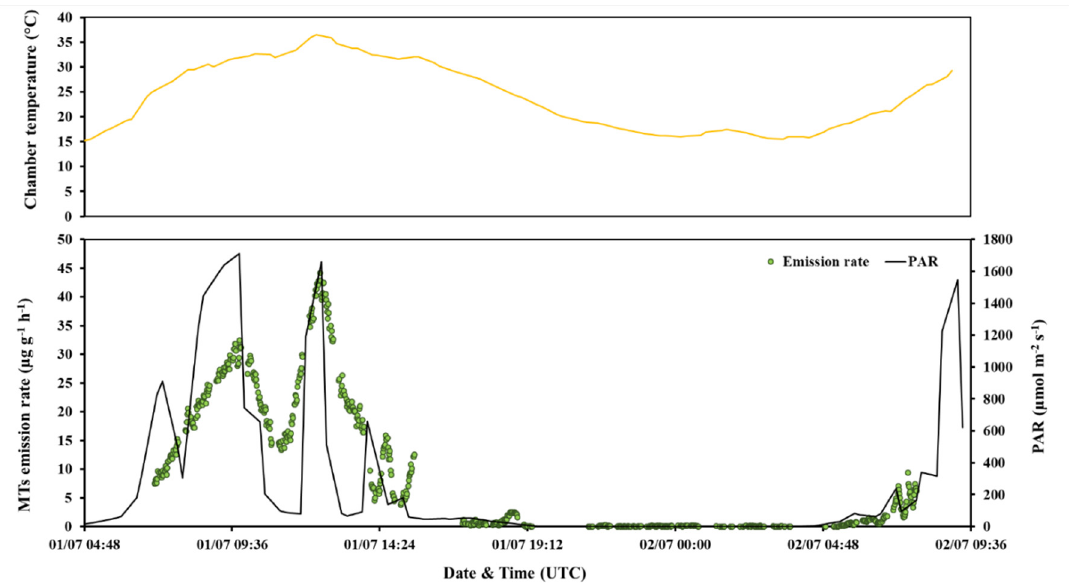
Figure 7. Diurnal variation of total MT emission rates with PAR and chamber temperature for Q. ilex II branch enclosure. Table 2. Summary of the operational conditions, meteorological parameters, mean and maximum emission rates of total MTs and the proportions of individual MTs for the four branch chambers.